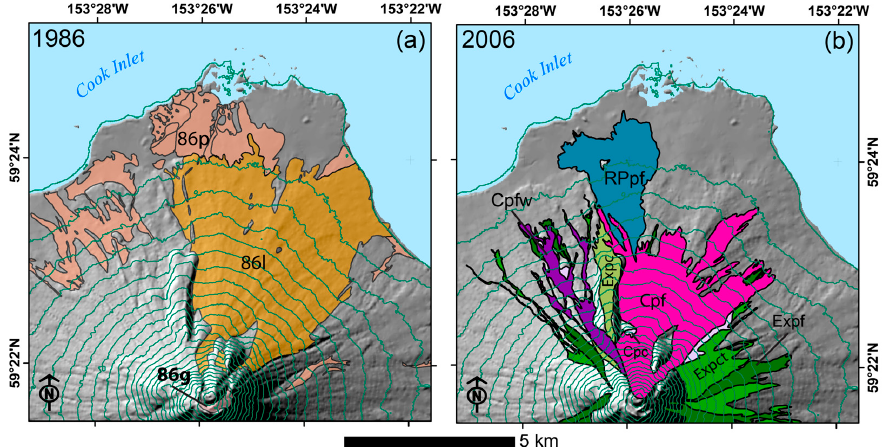
Figure 2. The north flank of Augustine Island with pertinent deposits from the 1986 and 2006 eruptions. From 1986 ( a ): 86l—Lithic PFD; 86g—Dome agglutinate and proximal fall; 86p—Deposits from pumiceous pyroclastic flows, mixed flows, and lahars (modified from Waitt et al., [17]). From 2006 ( b ): Cpf—Continuous phase PFDs; Cpc—Continuous phase pyroclastic current deposits; Cpfw—Windy PFD; RPpf—Rocky Point PFD; Expc—Explosive-phase pyroclastic current deposit; Expf—Explosive-phase PFD; Expct—Thin explosive-phase PFDs (modified from Coombs et al., [18]). Contour lines at 50 m.